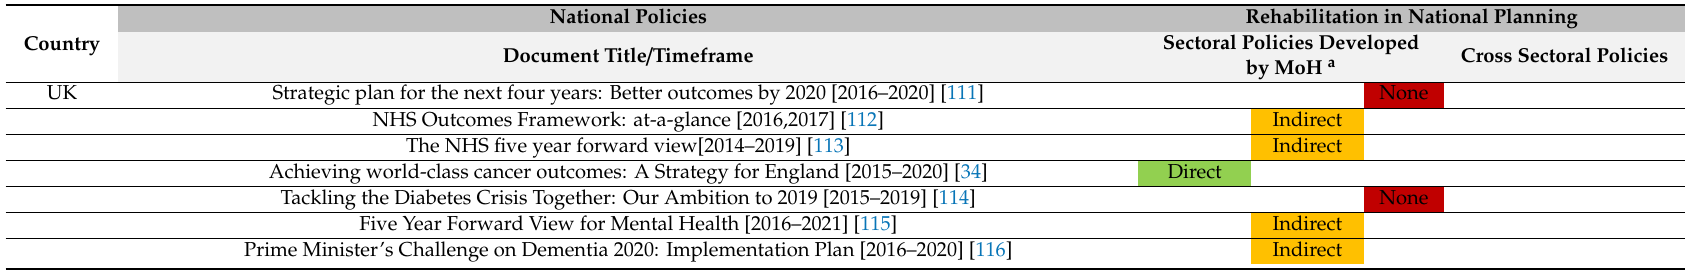
Table A2. Rehabilitation in national policies, strategies and action plans in the UK, Germany, Italy, the Netherlands and Sweden ( n = 29).